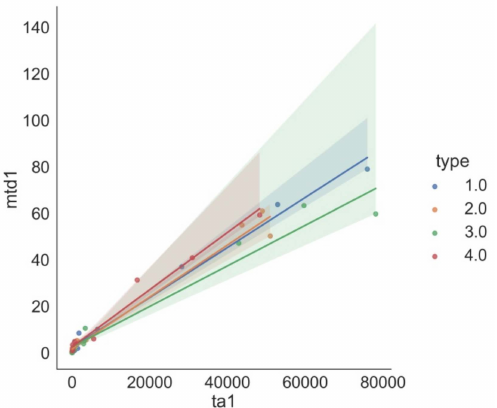
Figure 9. Maximum track depth versus track area—dry friction (positive correlation (0.98)).